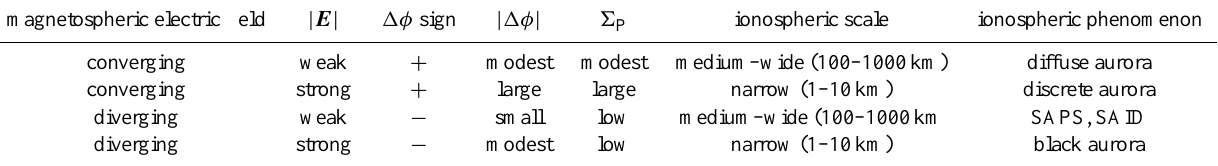
Table 1. Classification of auroral phenomena based on the properties of the current circuit for a simple converging/diverging electric field configuration. The underlying assumptions are that the return current is characterized by a higher Knight constant than the upward current, and that it is limited to a relatively low maximum